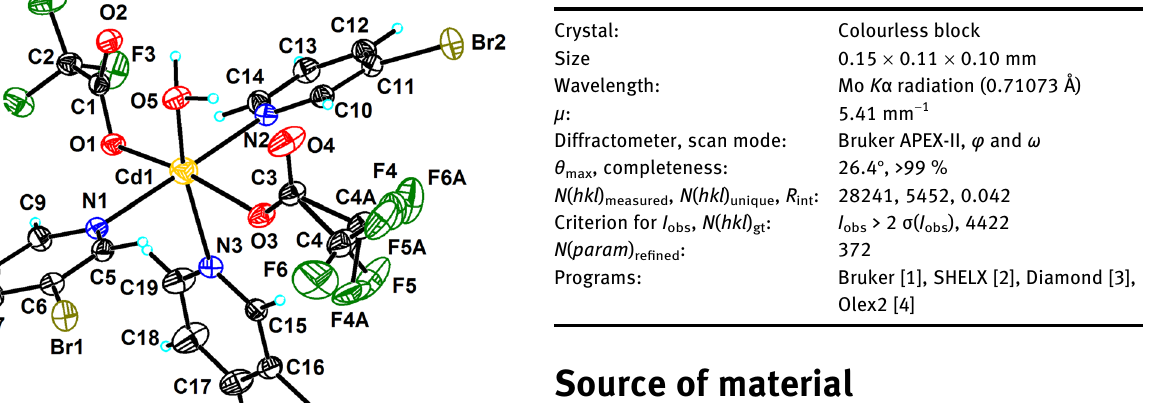
Table 1 contains crystallographic data, and Table 2 con- tains the list of the atoms including atomic coordinates and displacement parameters.